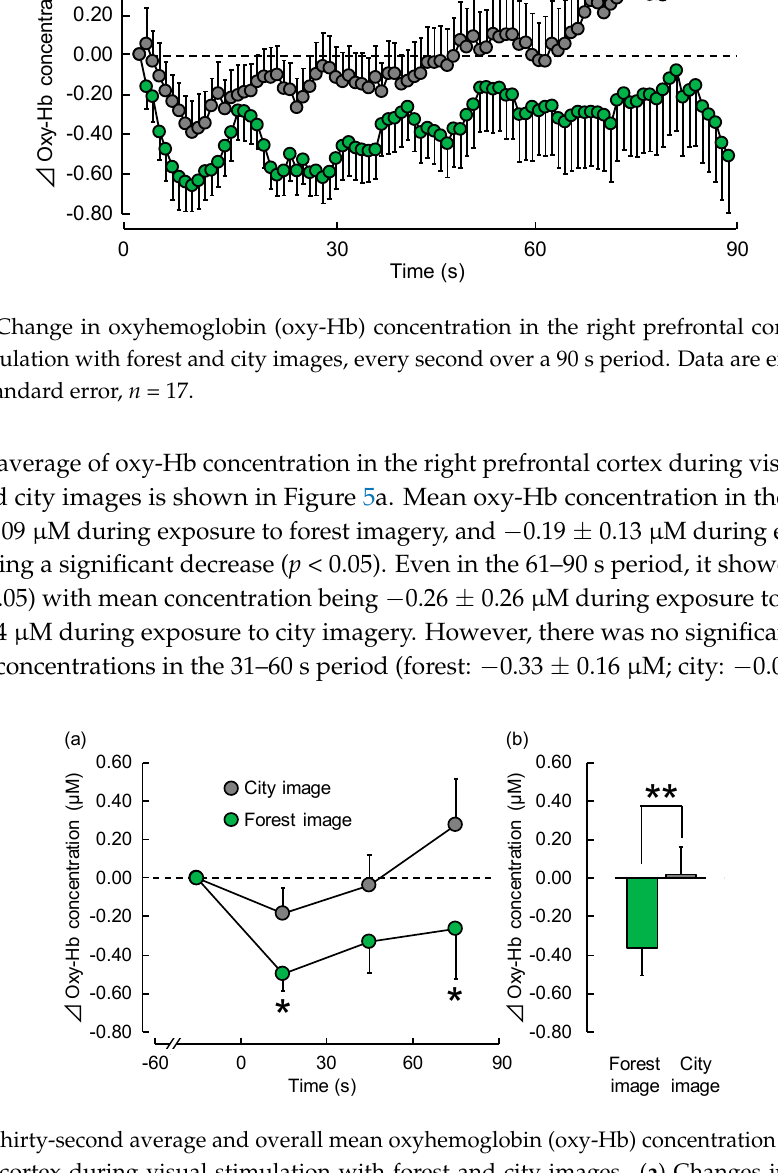
Figure 4. Change in oxyhemoglobin (oxy-Hb) concentration in the right prefrontal cortex during visual stimulation with forest and city images, every second over a 90 s period. Data are expressed as mean ± standard error, n = 17.